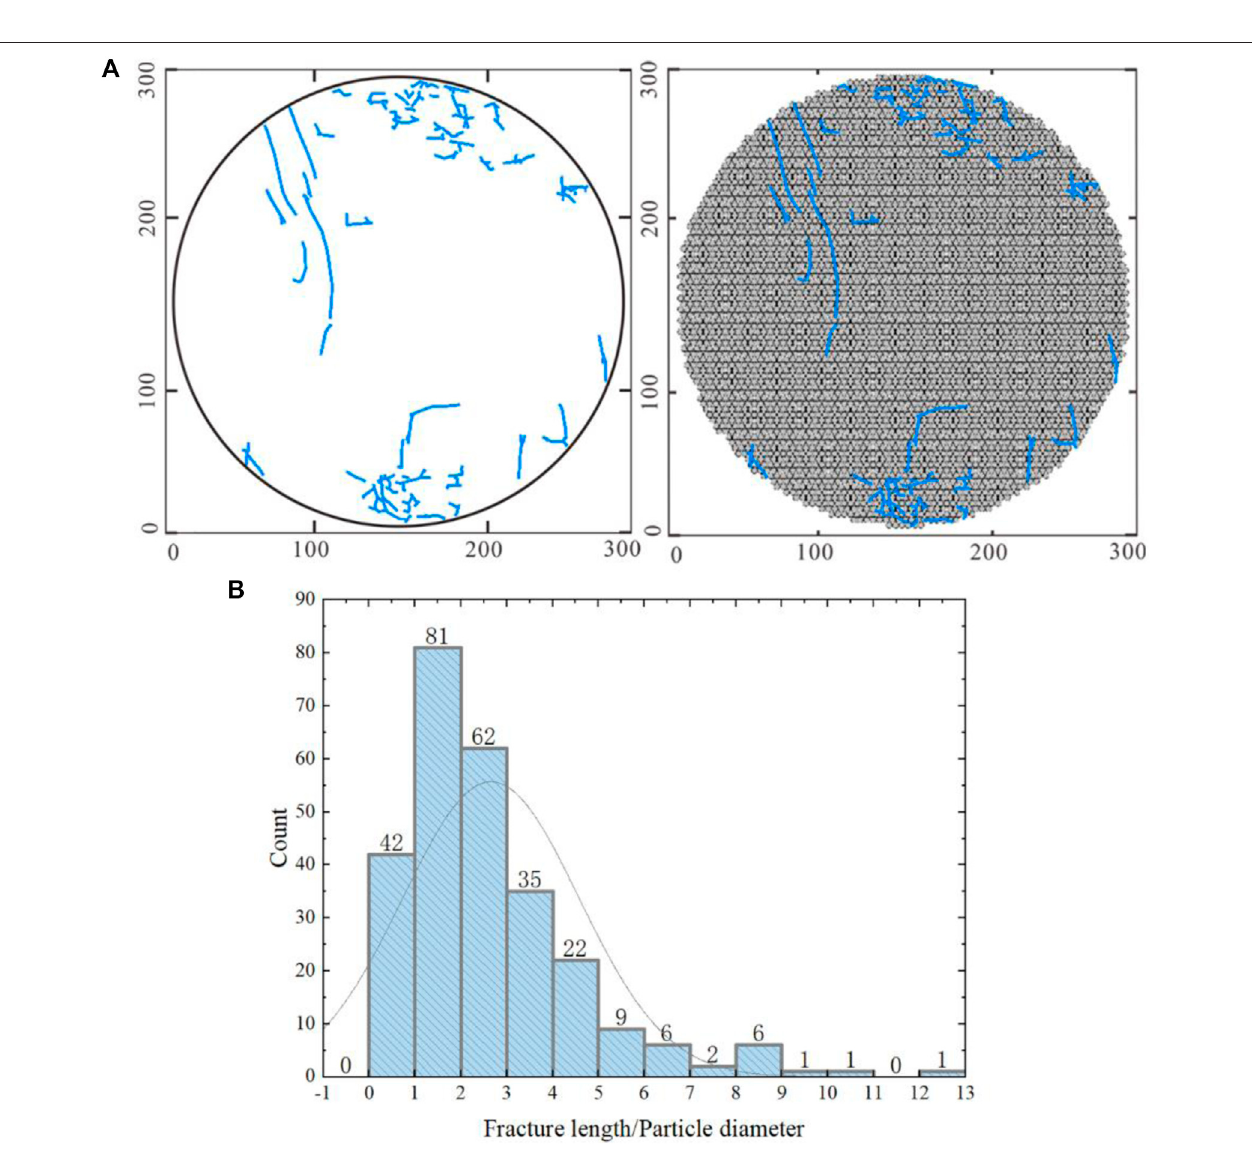
FIGURE 13 | (A) Rock sample with cracks (unit: m). (B) Crack length histogram.